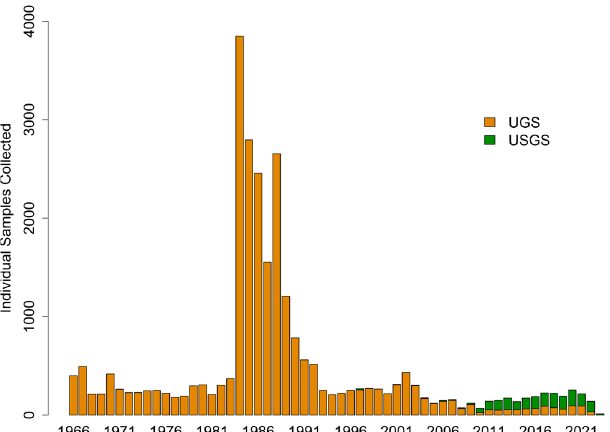
Figure 3. Annual count of individual UGS (orange) and USGS (green) samples over the historical record. Samples taken at different depths at a single site were counted separately.